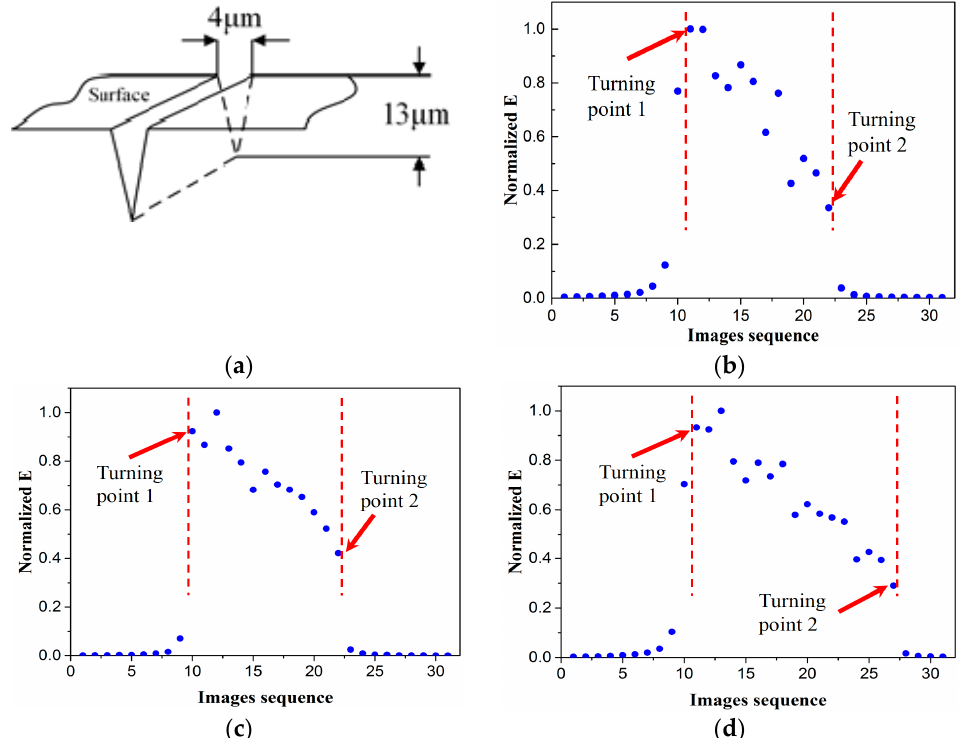
Figure 4. Definition curves of subsurface crack. ( a ) Schematic diagram of V-shaped crack; ( b )~( d ) Crack definition curves of 4 μ m wide and 13 μ m deep, 1 μ m wide and 13 μ m deep, 4 μ m wide and 18 μ m deep, respectively.